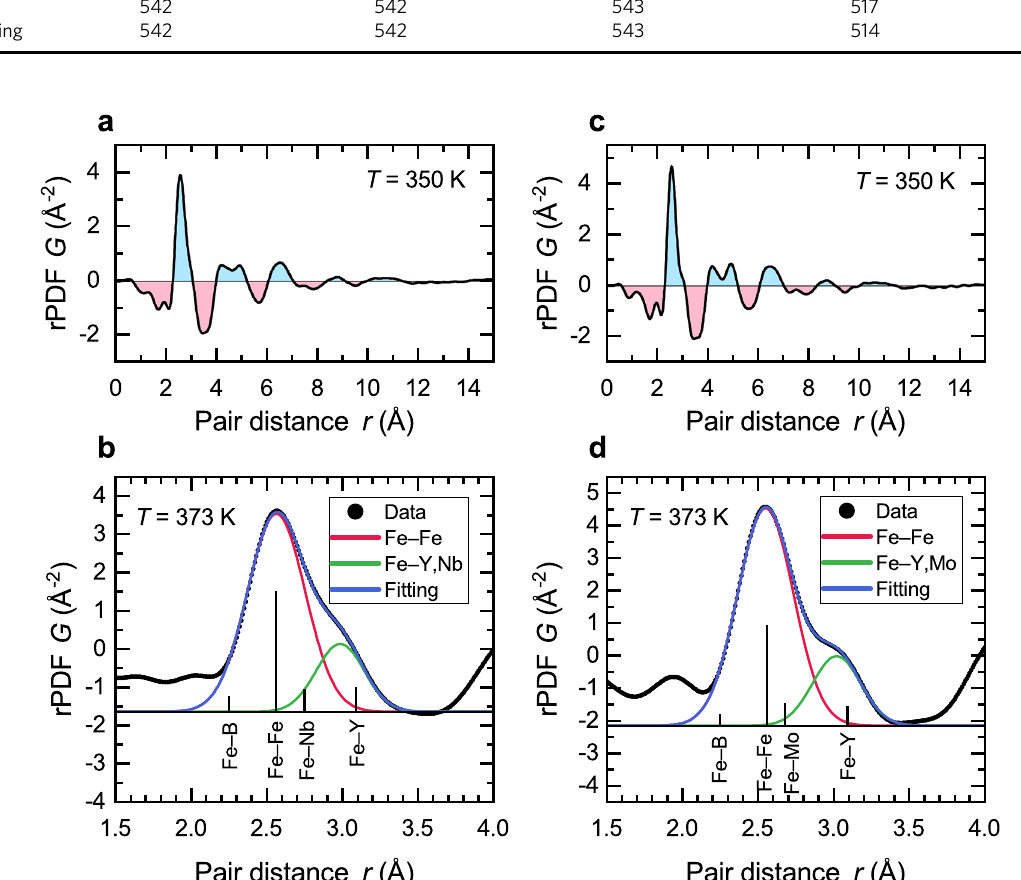
Fig. 5 Reduced pair distribution function of QNb and QMo. The rPDF shows fi ve atomic shells for both a QNb and c QMo. The fi rst atomic shell of b QNb and d QMo can be decomposed into two Gaussian distributions. The fi rst atomic shell is dominated by Fe – Fe pairs. Fe – Y and Fe – Nb/Mo pairs form a common distance distribution.